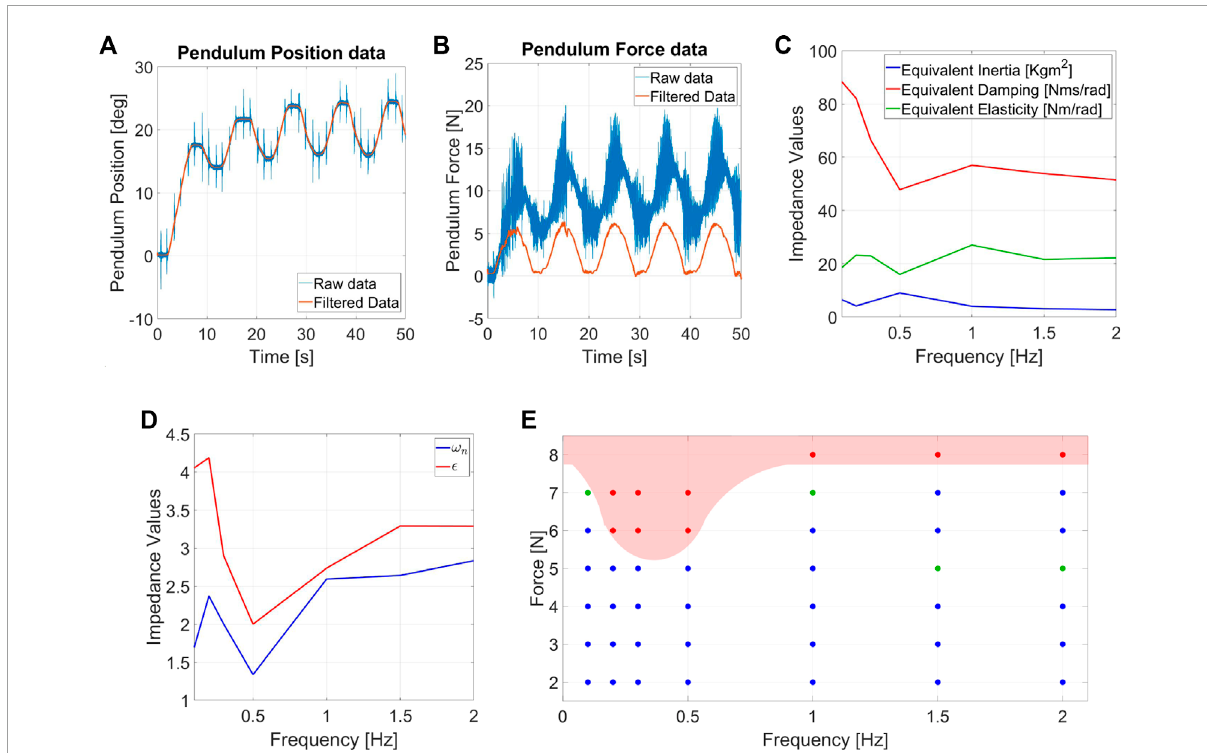
FIGURE 10 Measurement of (A) angular position and (B) force estimation for the sinusoidal force disturbance experiments. The used condition for the test are f = 0 . 1 Hz and A F = 3 N . (C) EEIand (D) Equivalent damping ratio ( ϵ ) and natural frequency ( ω n ) related to sinusoidal force protocols. (E) Chart of the ERrelated to repetitive forces for Alter-Ego.